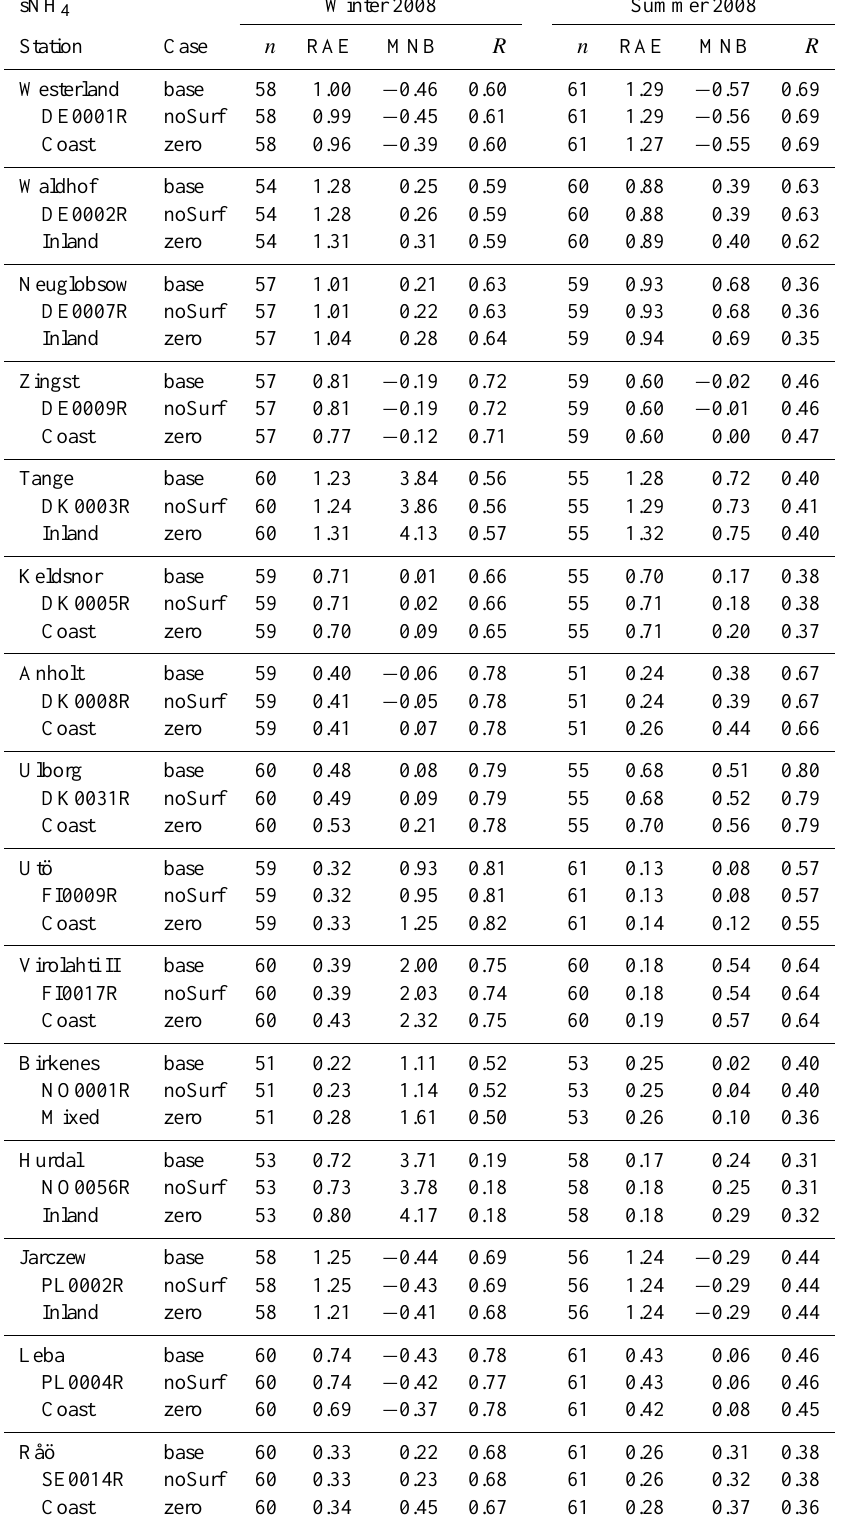
Table 3. Similar to Table 2 but showing sNH 4 (NH 3 + NH + are